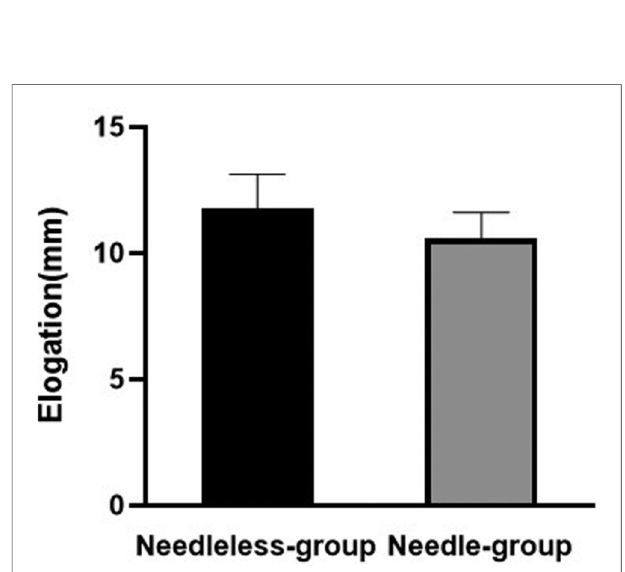
FIGURE 5 | The mean load elongation in the needle group and the needleless